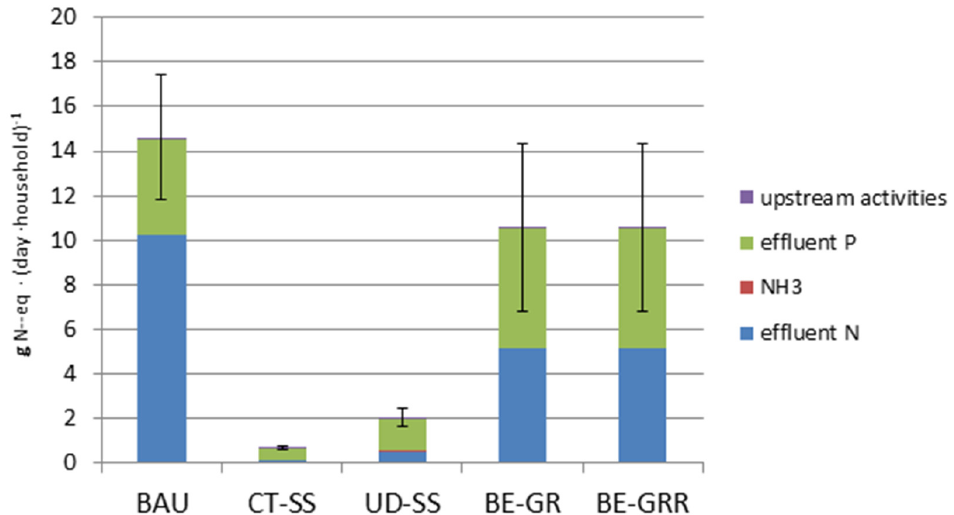
Figure 4. Life cycle eutrophication potentials of water systems, g N-eq·(day·household) − 1 . The range of variability bar presents the values at fifth and 95th percentiles.